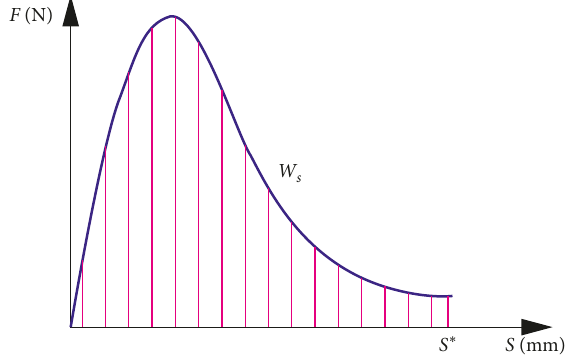
Figure 9: Energy dissipation during unconfined compression test.